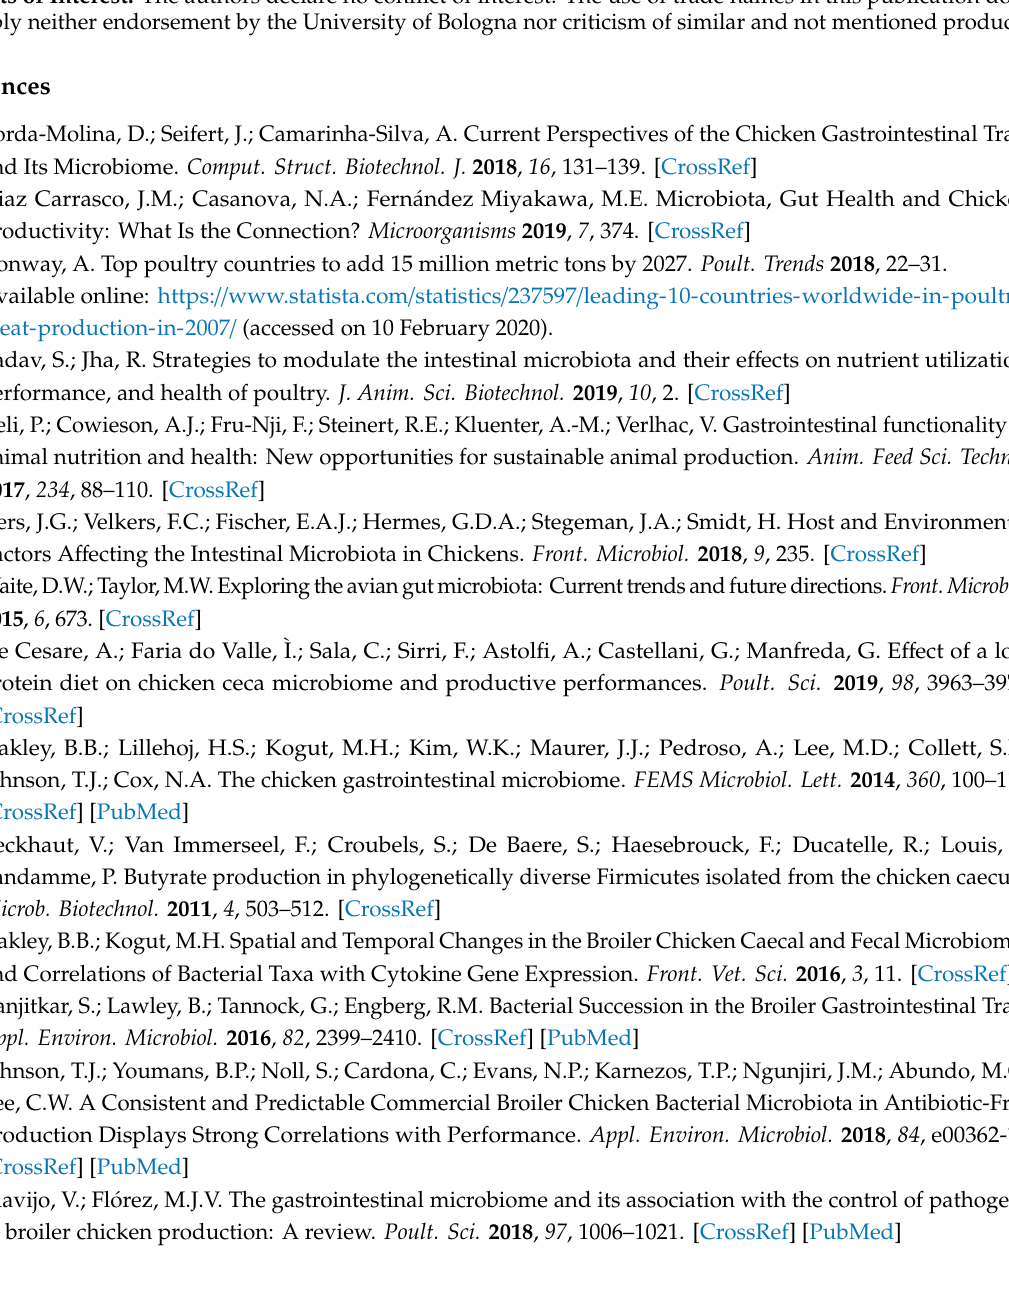
the caecal microbiota of broilers. Supplementary Table S1: Feed composition (%) in relation to di ff erent feeding phases. Supplementary Table S2: Vitamin B2 target and analyzed content in feed for each group, (mg / kg of feed and % vs. target), in the di ff erent feeding phase